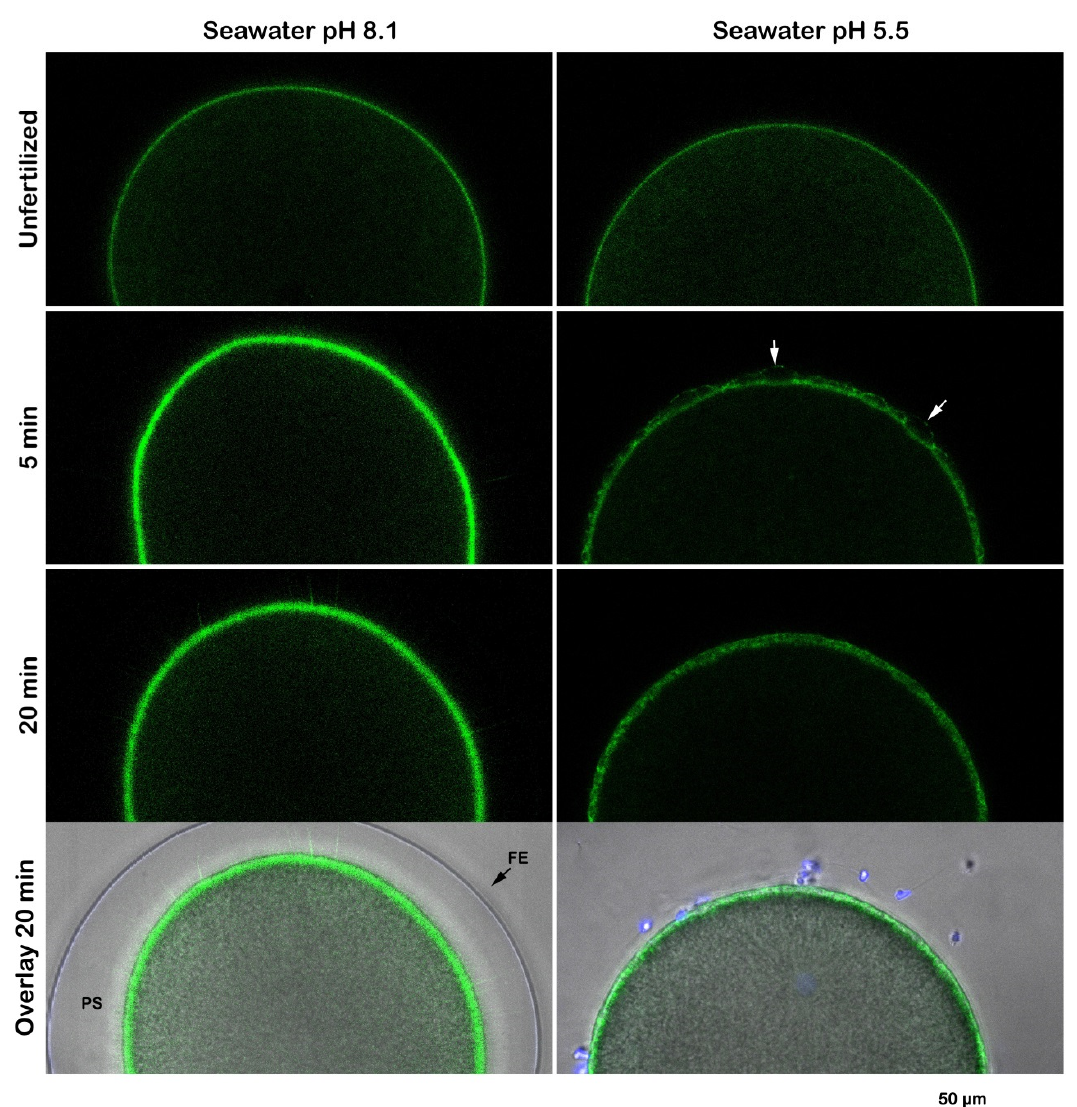
Figure 6. Changes of the cortical actin cytoskeleton in the jelly-free sea urchin eggs inseminated in acidic seawater (pH 5.5). P. lividus eggs injected with the LifeAct-GFP fusion protein were inseminated either in NSW (pH 8.1) or in acidic seawater (pH 5.5, after preincubation). In the control eggs, the cortical actin underwent polymerization to form a thick layer beneath the plasma membrane by 5 min after insemination, which persisted for 20 min. By contrast, in the eggs incubated and inseminated in acidic seawater, even if a thin layer of actin was detected in the unfertilized eggs, the lower pH of the seawater prevented the cortical actin polymerization from normally occurring 5 min after insemination. The fluorescent and overlay images show a weaker and discontinuous polymerized layer 20 min after insemination. Full elevation of the FE was compromised due to the attachment of the FE with the egg surface in several regions of the egg surface (arrows). Sperm were seen attached to the egg surface 20 min after insemination (see also Figure 2D).